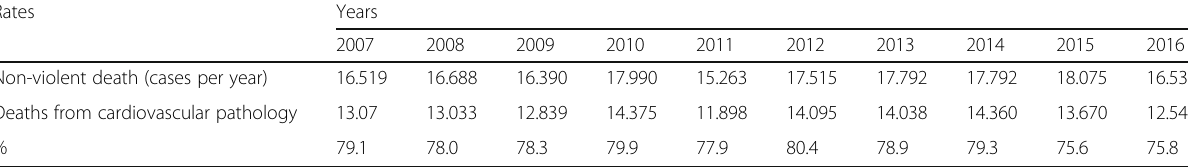
Table 1 Rates for sudden death in Moscow (2005 –